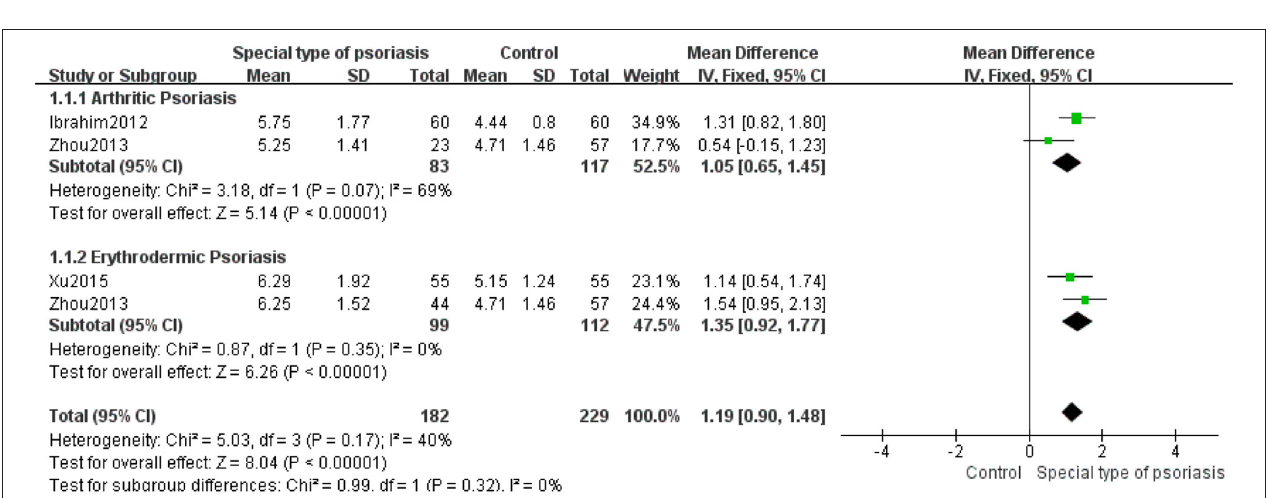
FIGURE 7 | Meta-analysis of the prevalence of hyperuricemia in psoriasis patients vs. controls by sex. OR for psoriasis in subjects with hyperuricemia compared with total subjects. The point estimate (center of each blue square) and statistical size (proportional area of the square) are represented. The horizontal lines indicate the 95% confidence intervals. The pooled OR (diamond) was calculated using a fixed-effects model. OR, odds ratio.